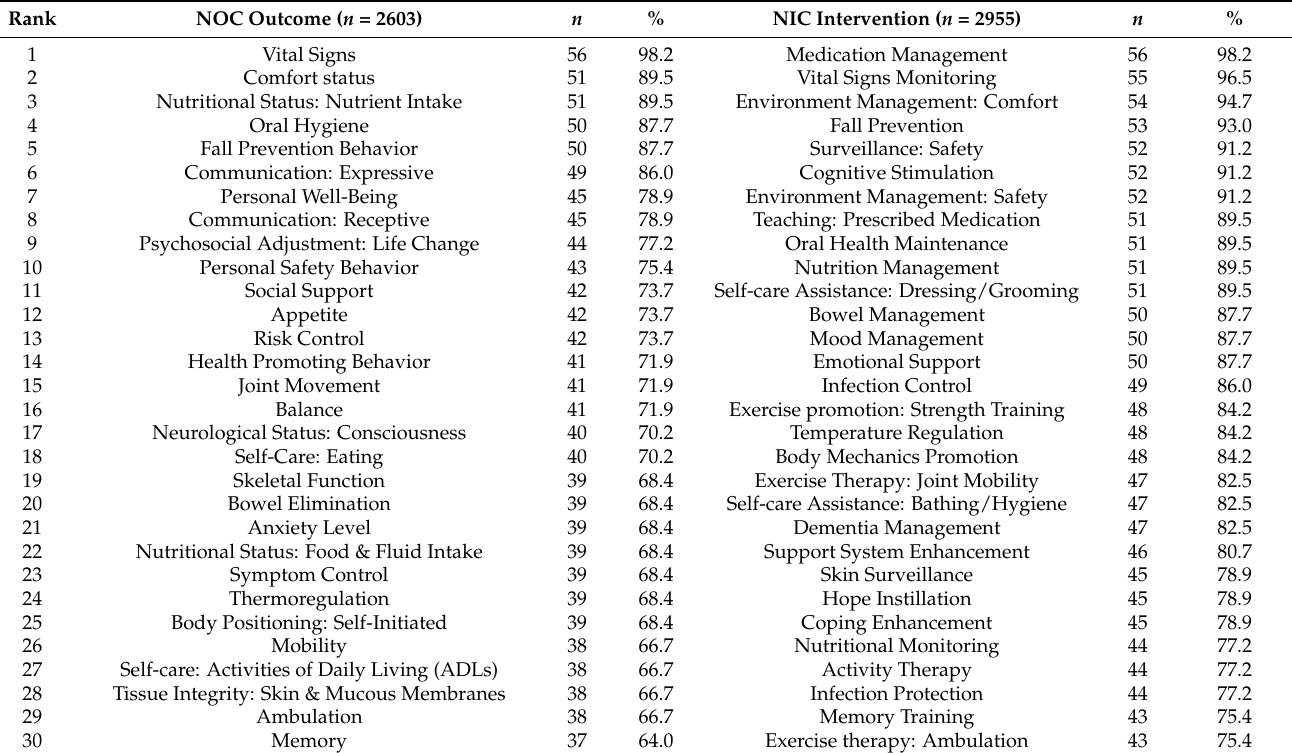
Table 3. Frequency of Top 30 NOC outcomes and NIC